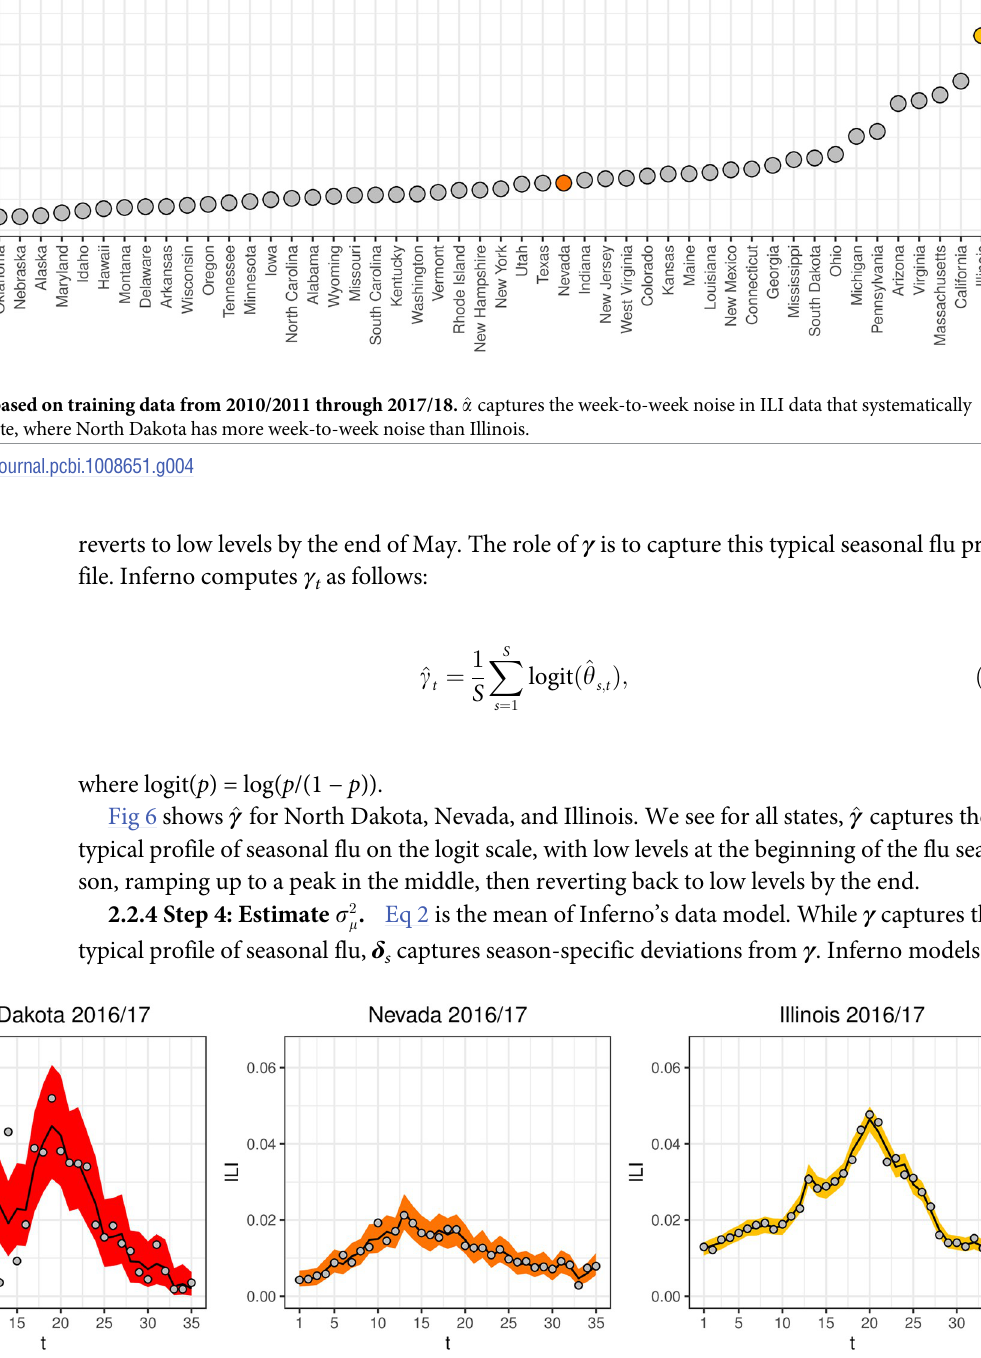
; ^ a ð 1 (cid:0) ^ y ÞÞ (ribbon) for North Dakota, s ; t s ; t